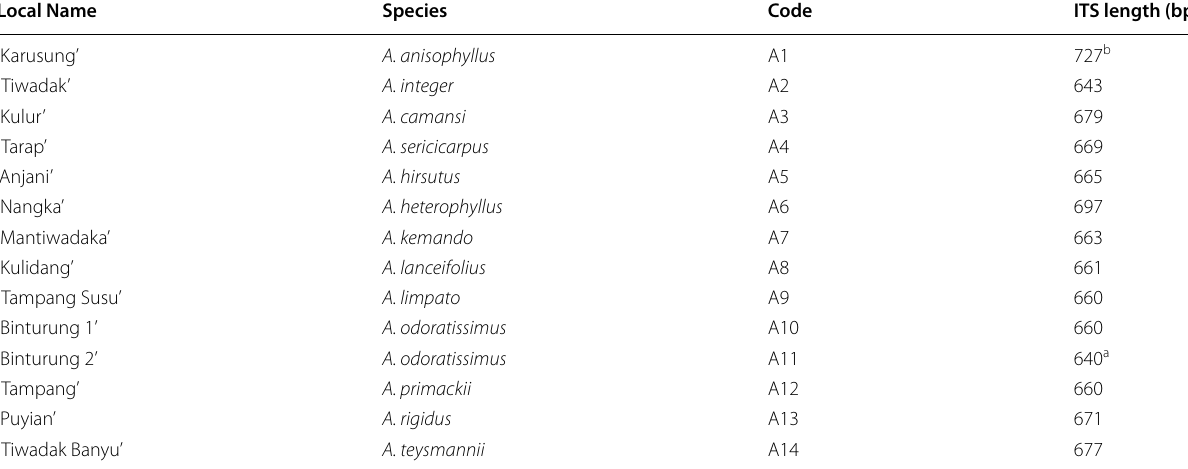
Table 2 Endemic breadfruit species ( Artocarpus spp.) used in the study, including the length of ITS